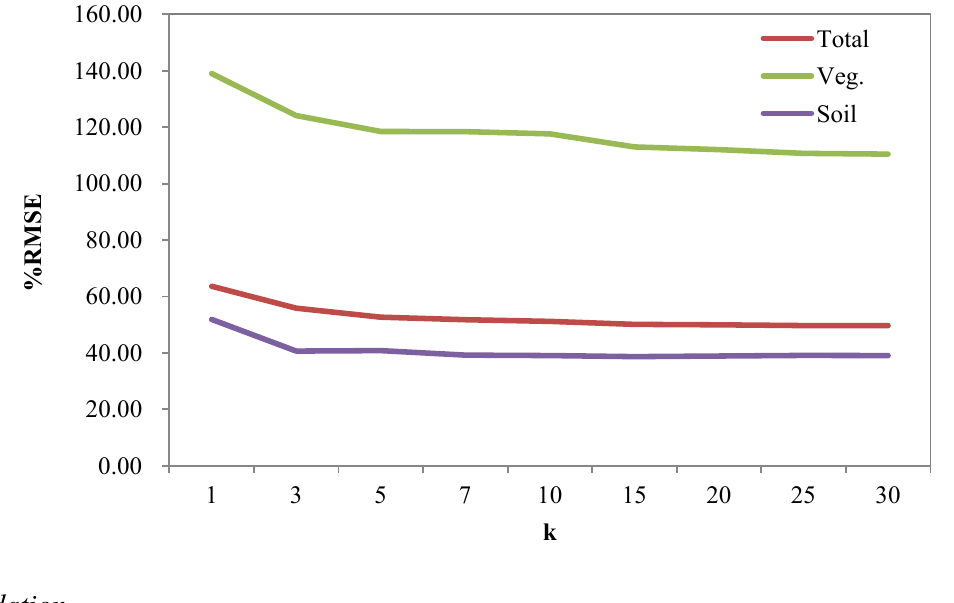
Figure 2. Sensitivity analysis based on Root Mean Square Error (RMSE) for k = 1 to k =